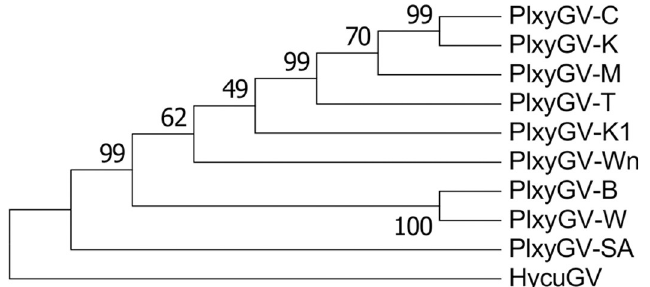
Fig 6. Neighbor joining phylogenetic tree of PlxyGV isolates. The phylogeny was inferred using concatenated amino acid sequences of the homologs of thirty eight baculovirus core genes of nine PlxyGV isolates.